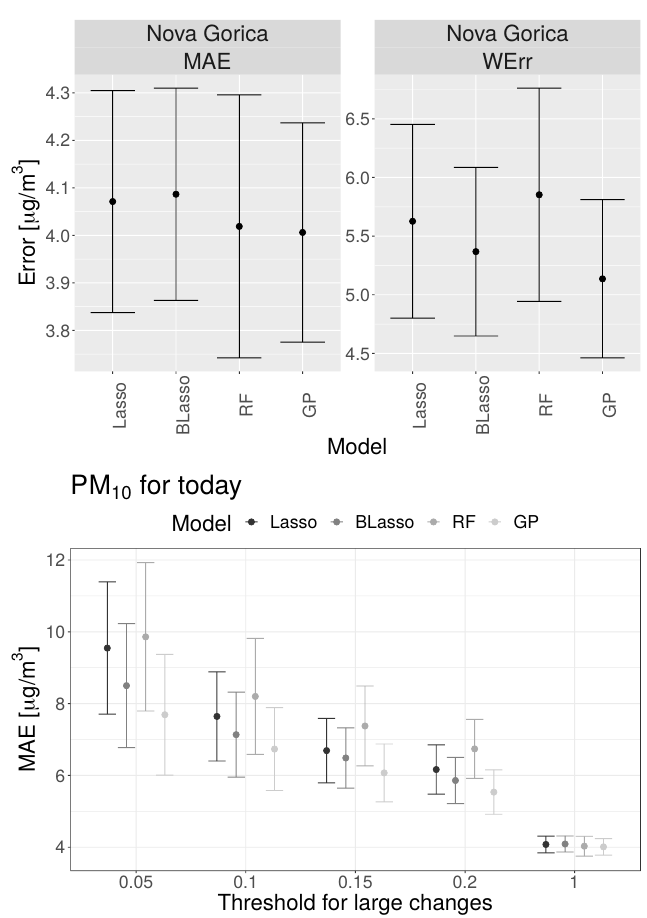
Figure 7. The top left figure shows MAE for different models for PM 10 prediction for today in Nova Gorica, while figure top right shows WErr for the same models. The lower figure shows MEA for different ∆ C(1